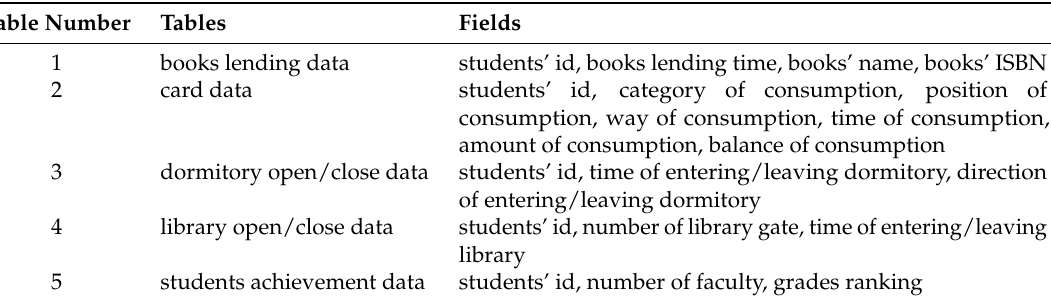
Table 1. Details of the dataset utilized in our experiments.